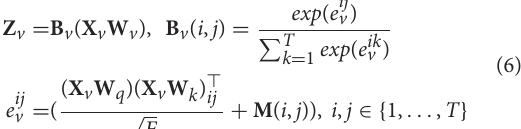
2020; Qiu et al., 2020; Li et al., 2021; Xu et al., 2021; Zhou et